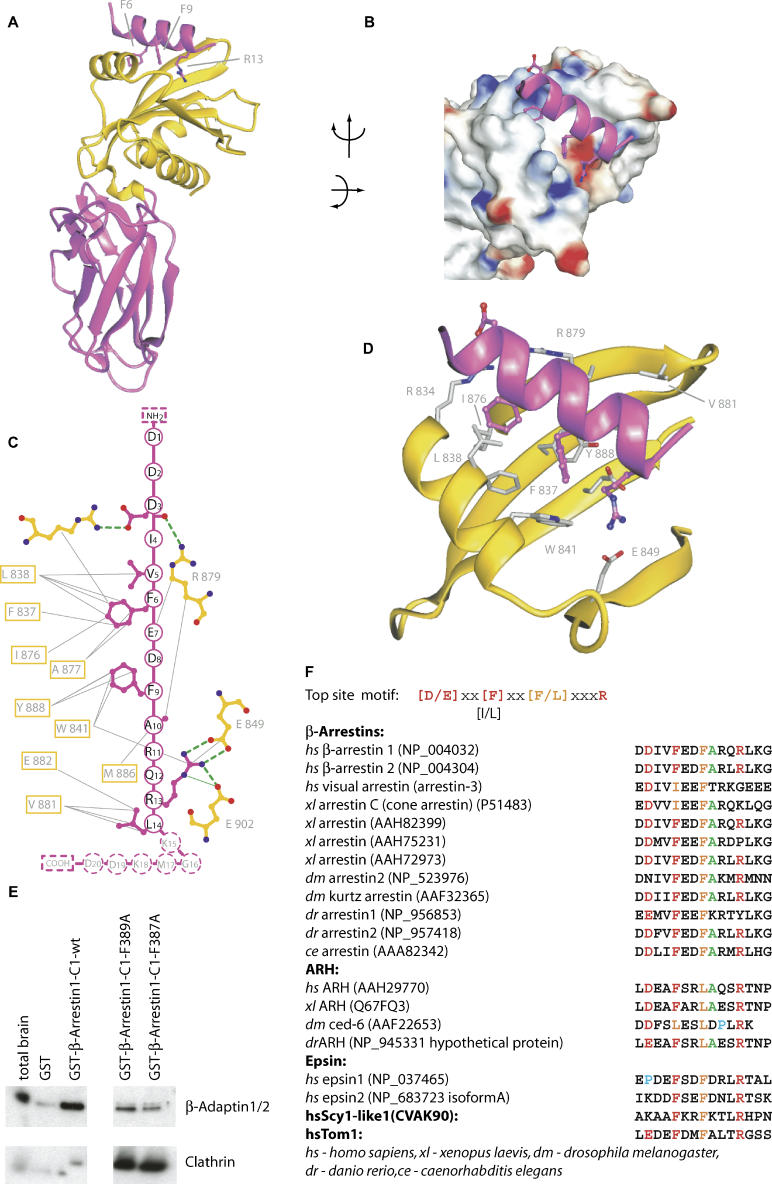
Peptide from the C-Terminus of β-Arrestin Folds as a Helix in a Groove on the Platform Sub-domain of the β2-Appendage(A) Ribbon diagram showing peptide in purple bound to top site of the platform sub-domain of the β-appendage as an α-helix.(B and D) The peptide binds into a groove with interacting residues of the peptide lining one side of the helix. The top of the groove is generally positive and D3 of the peptide is found here. F6 and F9 are in apolar environments and there is limited space for F9. R13 binds to the negatively charged patch of the groove.(C) Peptide displayed as a linear chain showing hydrogen-bonding potential (green lines) and hydrophobic interactions (grey lines). Hydrogen bonds within the α-helix of the peptide are not shown for clarity. The residues for which there is little density are dotted.(E) Mutagenesis of the Phe residues of β-arrestin DxxFxxFxxxR motif prevent the binding of AP2 complexes to GST-β-arrestin C1 in brain extracts.(F) Conservation of the interaction motif between arrestins and ARH and possible motifs from epsin and CVAK90.